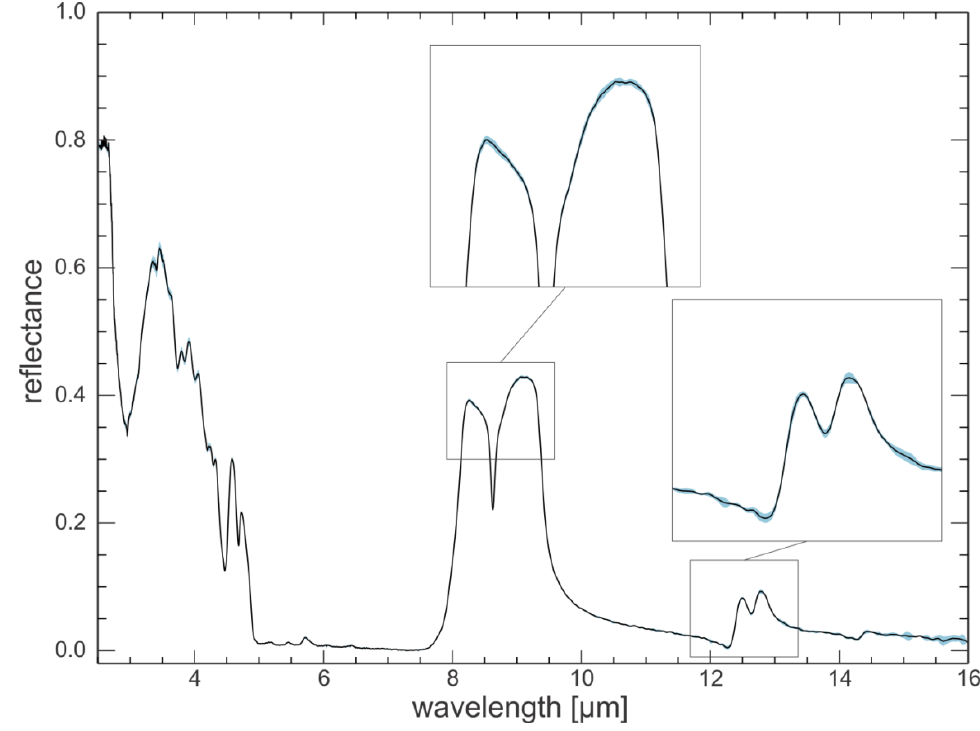
Figure 7. Long term reproducibility test. Mean spectrum (black line) of four quartz sand measurements taken over the course of twenty months, and the corresponding standard deviation (light blue band). Standard deviations are in the range 0.002 to 0.006 for most